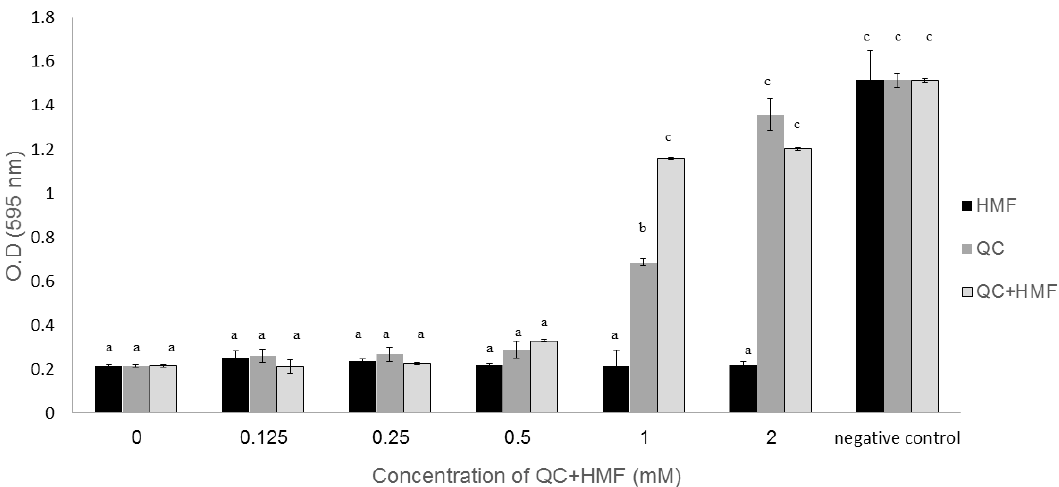
Figure 2. The e ff ect of 4-quinolinecarboxaldehyde (QC) and 5-hydroxymethyl-2-furaldehyde (HMF) on spiroplasma growth. Each compound was applied to a spiroplasma culture (5 µ L containing approximately 10E8 cells / mL and 150 µ L medium) in di ff erent concentrations, separately and combined. Low OD represents a change in color from red to yellow, indicating culture growth; high OD represents no change in color, indicating no growth. OD reads were taken at 594 nm by an ELISA plate reader three days post inoculation and incubation at 28 ◦ C. Sterile medium containing 20 µ L of each of the fractions was used as a negative control. Each treatment was performed in five repeats. Di ff erent letters represent significant di ff erences in growth between treatments ( t -test, p < 0.05). Standard error bars are